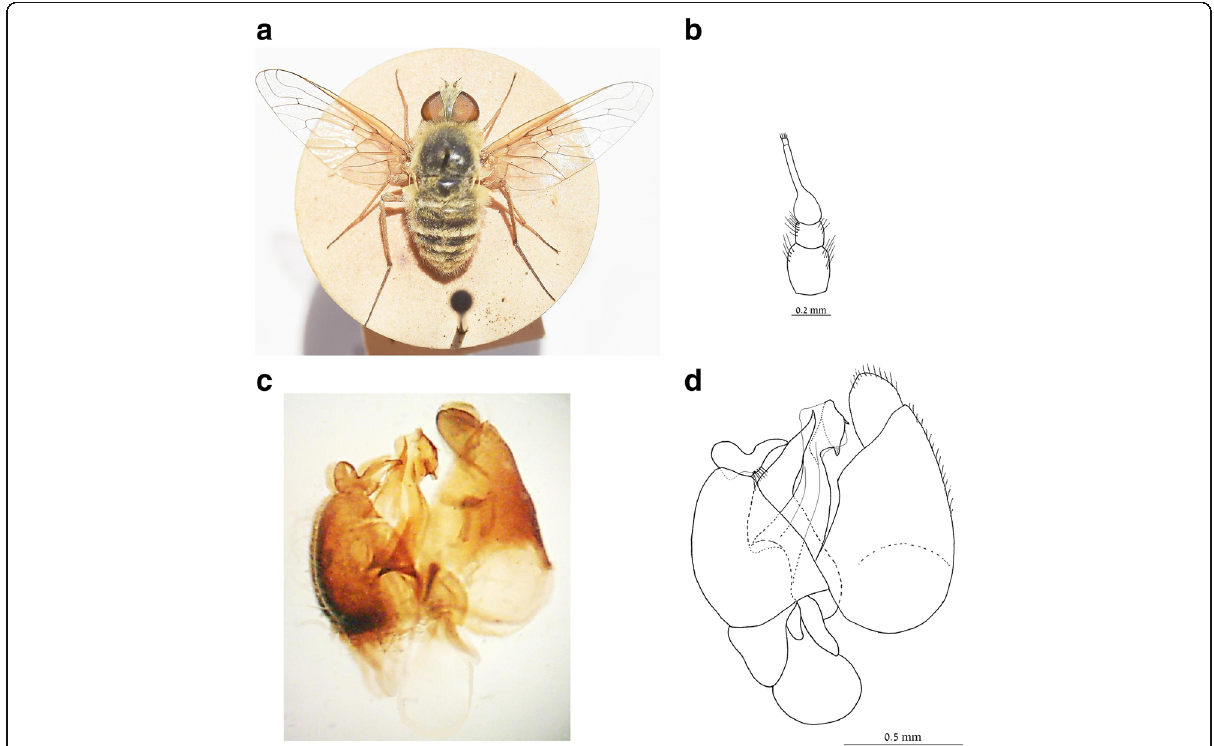
Fig. 2 Spogostylum niphasoides sp. nov. a Habitus. b Left antenna. c , d Male genitalia, lateral